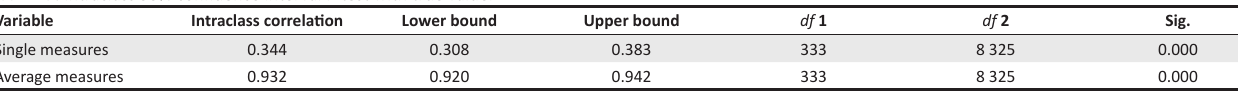
TABLE 7: Intraclass 95 % confidence interval F-test with true value.